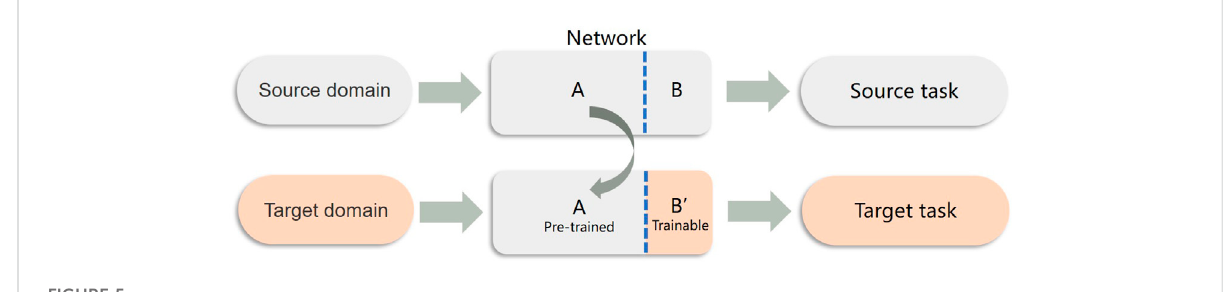
FIGURE 5 Demonstration of transfer learning.